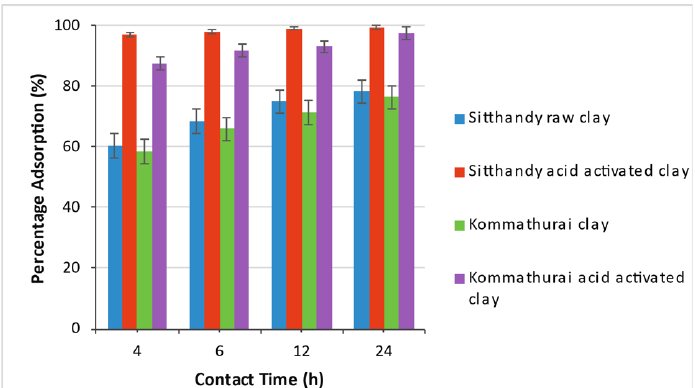
Figure 3: Effect of contact time on adsorption of CR by different clays (Initial dye concentration 400 mg L -1 ).